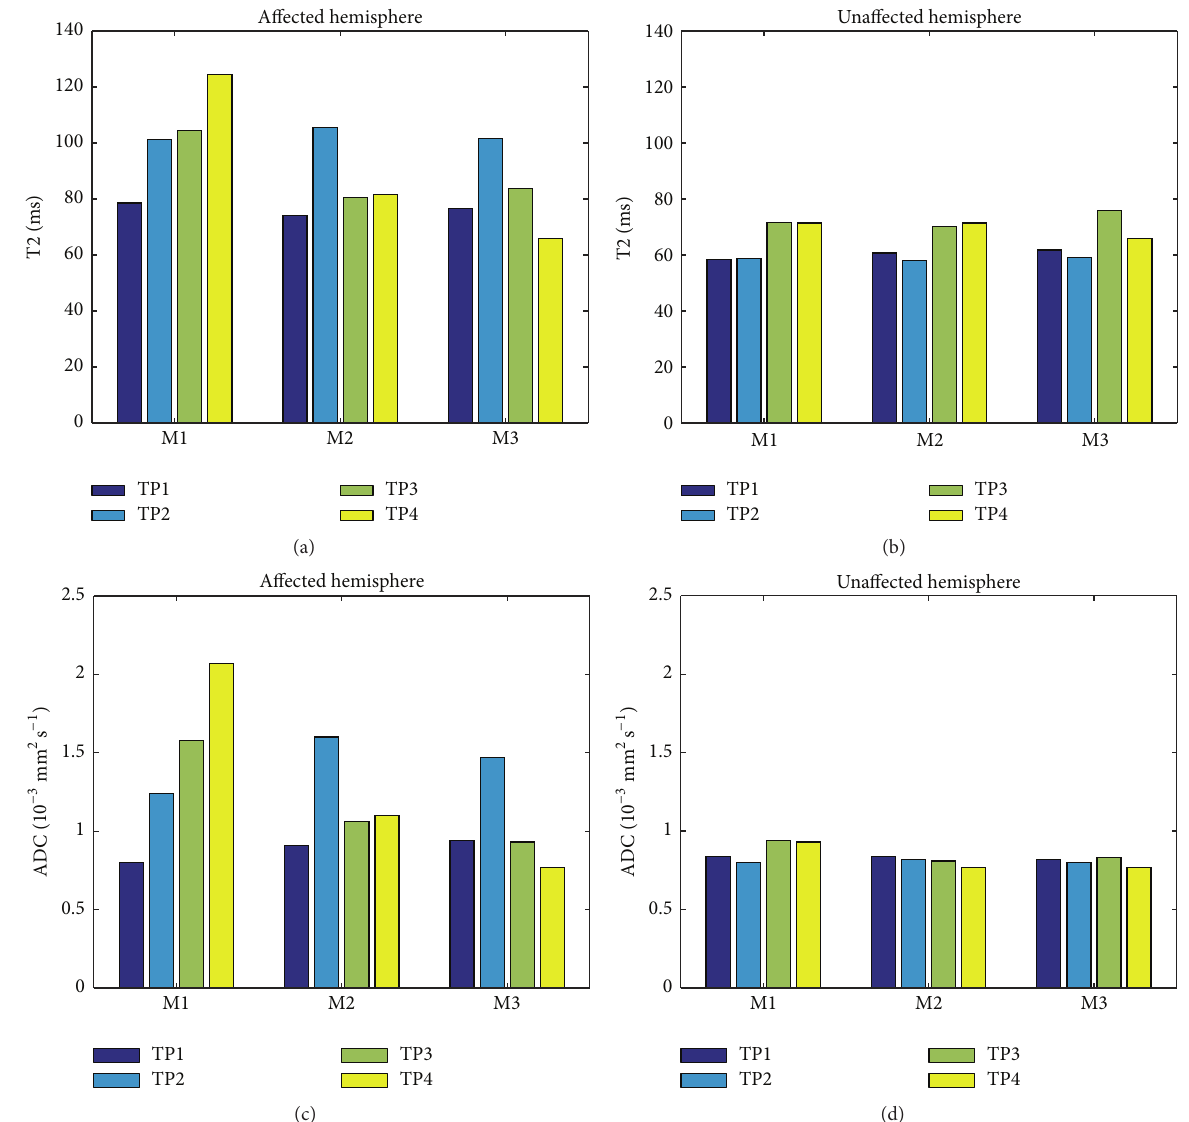
Figure 5: Measured T2 and ADC of the affected and unaffected hemispheres. A quantitative evaluation from MRI T2 sequence ((a), (b)) and ADC (Apparent Diffusion Coefficient) sequence ((c), (d)) maps of each rat during the different time points. The right (affected) and left (unaffected) hemispheres were compared at different time points as described in Figure 4 (TP1–TP4) in untreated animal group (M1) and treated groups as described in Figure 4 (M2,